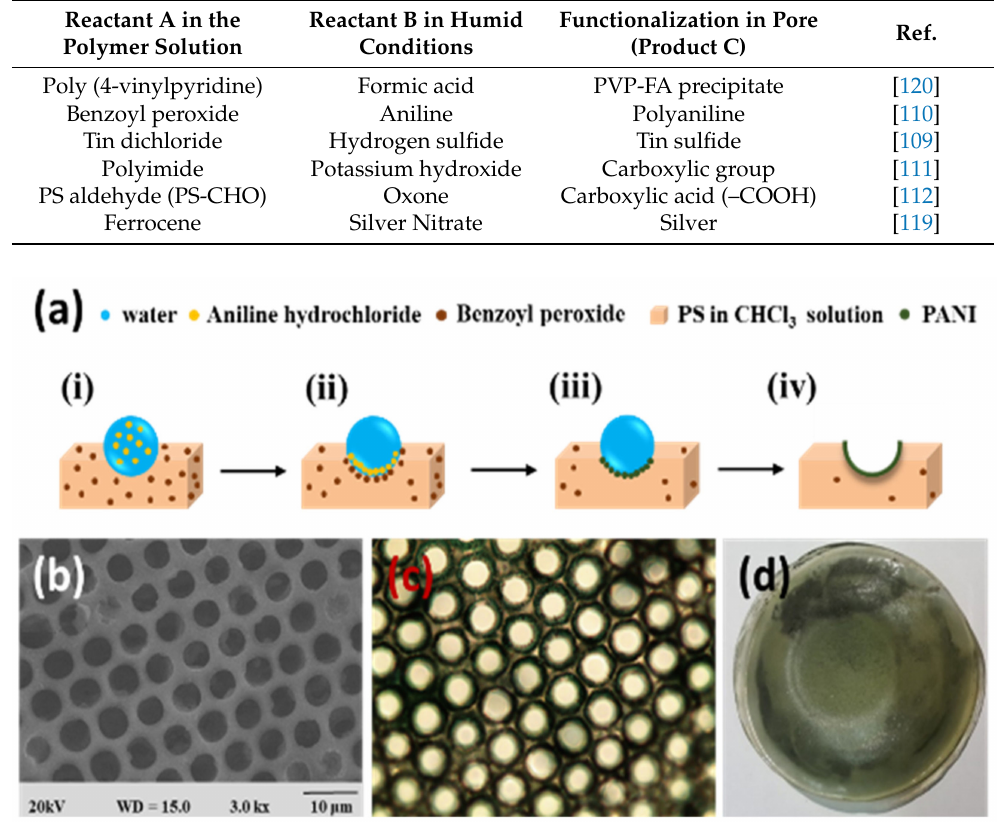
Figure 16. ( a ) Mechanism showing the formation of PANI-f-PS film with PANI functionalized pores: (i) Condensed aq. aniline hydrochloride droplets on PS-BPO solution during BF process, (ii) assembly of aniline hydrochloride and BPO at aqueous droplet/polymer solution interface, (iii) interfacial polymerization, (iv) and formation of PANI functionalized pores after completion of reactive BF process. ( b ) SEM, ( c ) optical, and ( d ) digital photograph of PANI-f-PS film. Reprinted with permission from ref. [110]. Copyright 2017